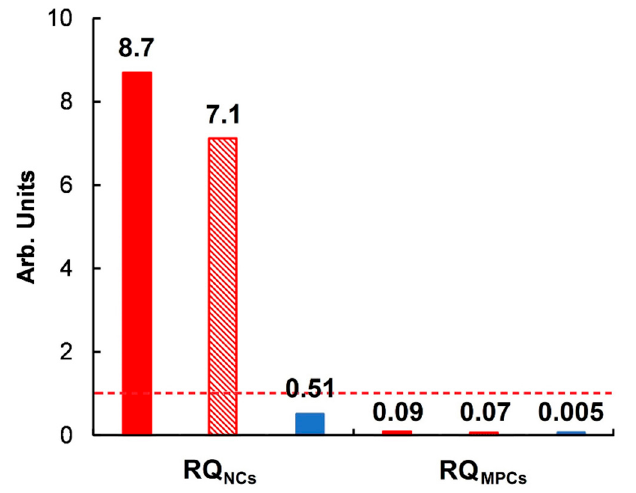
Figure 7. Assessment of the eco-toxicity of water pollution by Ʃ PAHs. Mean values of RQ NCs and RQ MPCs for the Ʃ 8 ПАУ concentrations (the total amount of the detected priority PAHs) in the water samples from the upper water layer collected in the southern basin of Lake Baikal in June 2016— , in the northern basin of Lake Baikal in September 2019— , and in the pelagic zone of Lake Baikal during the 2020 season— .